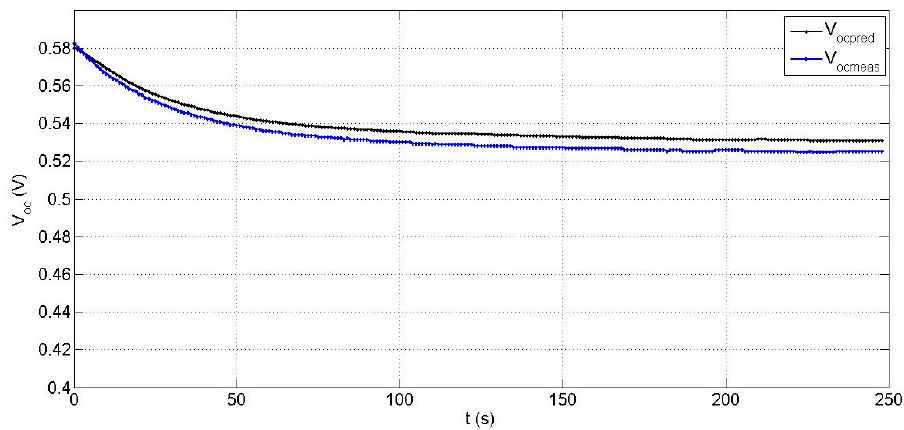
Figure 4. Predicted V oc,pred (t) and measured V oc,meas (t) profiles for a bare c-Si cell in controlled laboratory conditions.